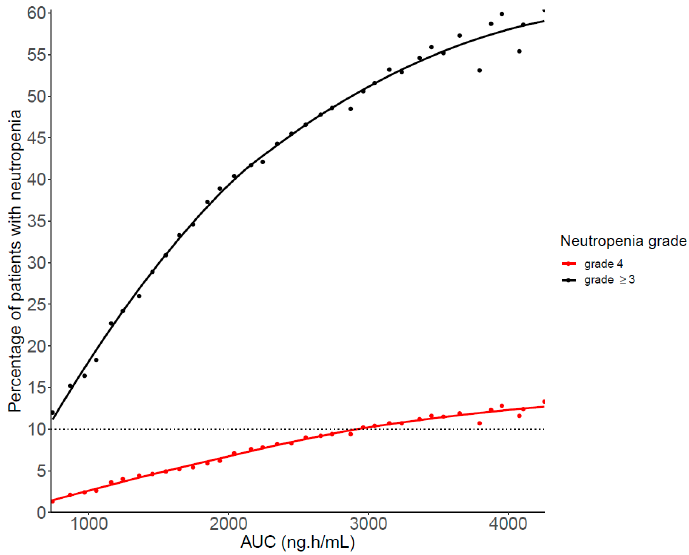
Figure 5. Incidence of grade ≥ 3 or grade 4 neutropenia according to palbociclib AUC 0–24 . The dotted line represents the empirical value of 10% of patients at risk of severe neutropenia as a maximum threshold not to be exceeded.